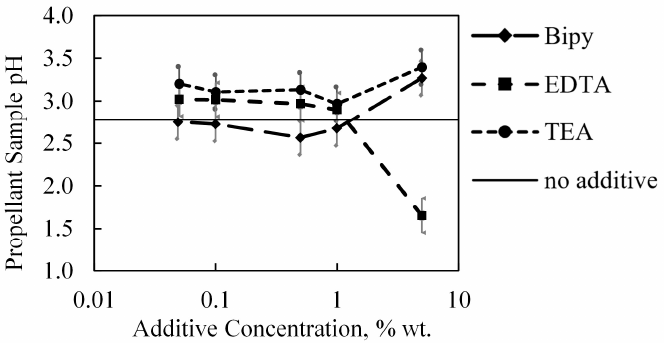
Figure 1. pH of HAN samples with chelating additives measured at room temperature.